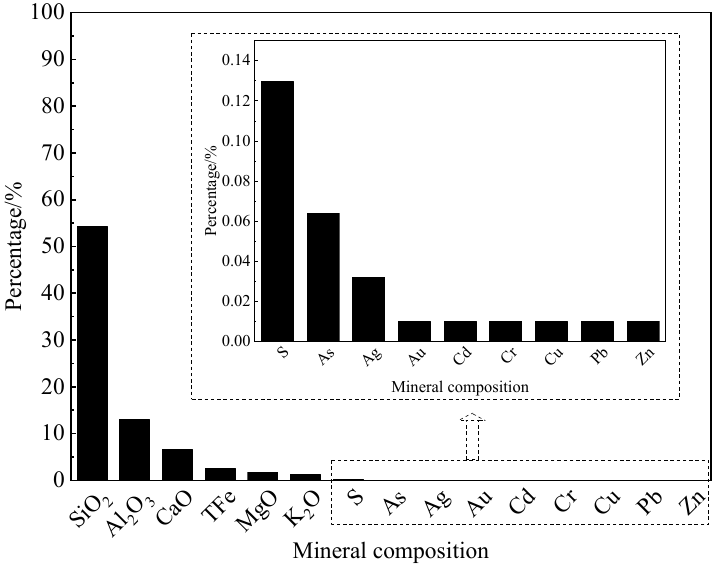
Figure 1. Chemical components (oxide analysis) of the studied gold mine tailings.